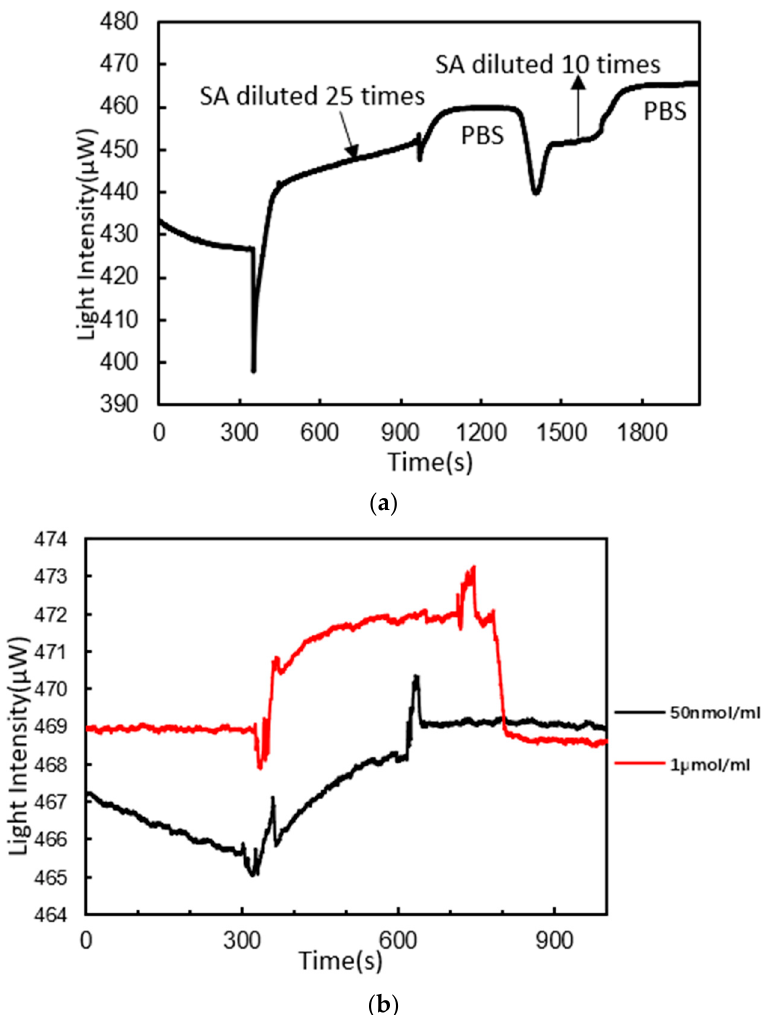
Figure 7. ( a ) Reaction curve of streptavidin (SA) binding to BSA; ( b ) reaction curves of DNA probes binding to SA.